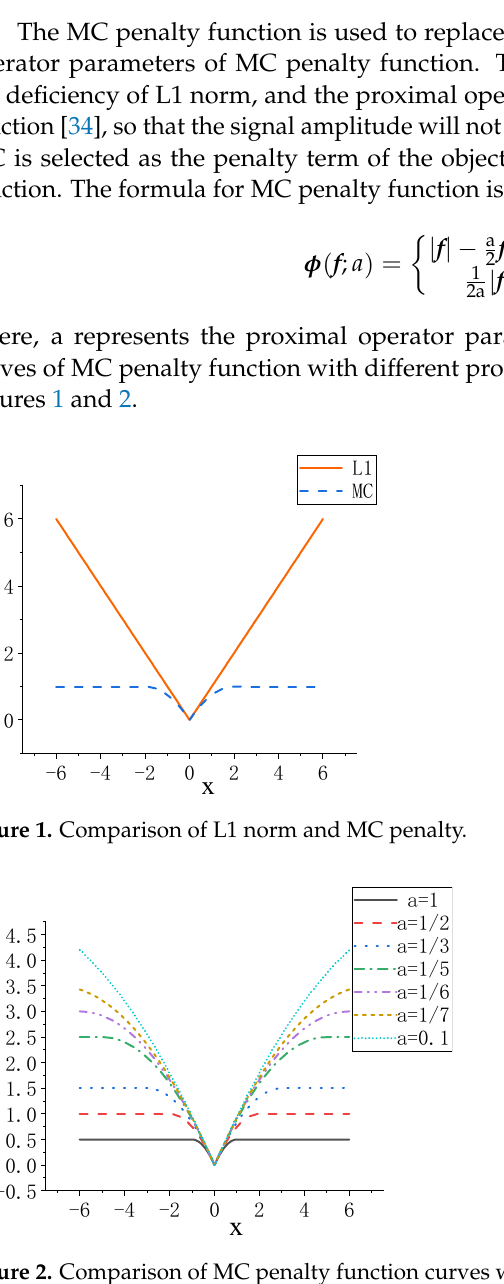
Figure 2. Comparison of MC penalty function curves with function (a = 1/2) curve.